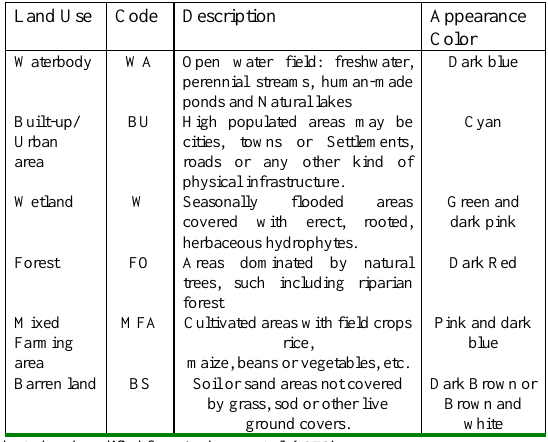
Table 2. Landuse classes for the study.